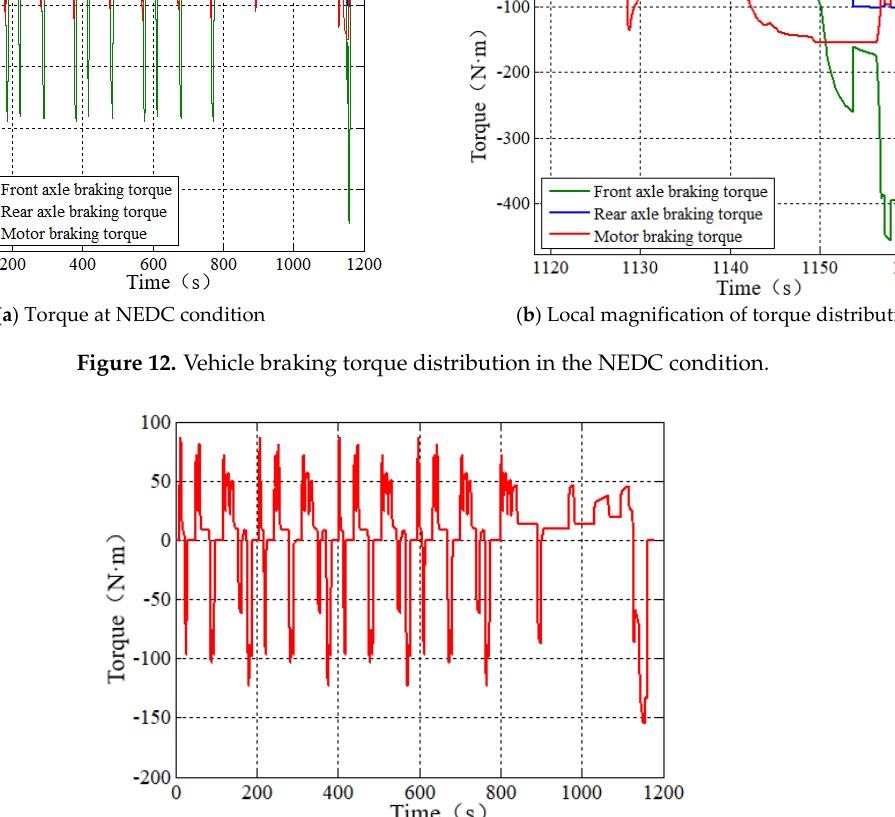
Figure 12. Vehicle braking torque distribution in the NEDC condition